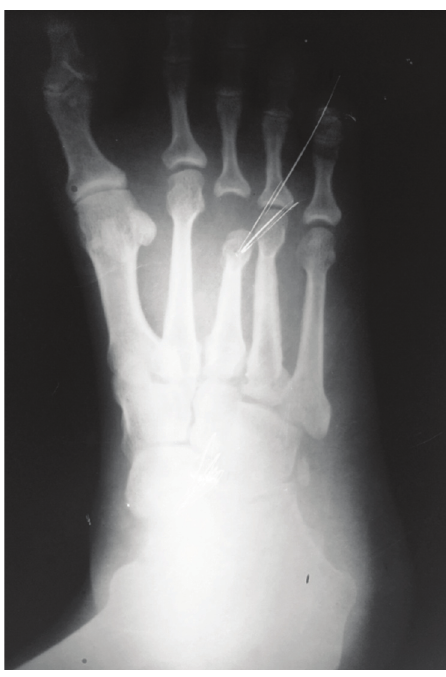
six weeks after closed reduction and immobilisation showing normally aligned 3rd MTP joint without